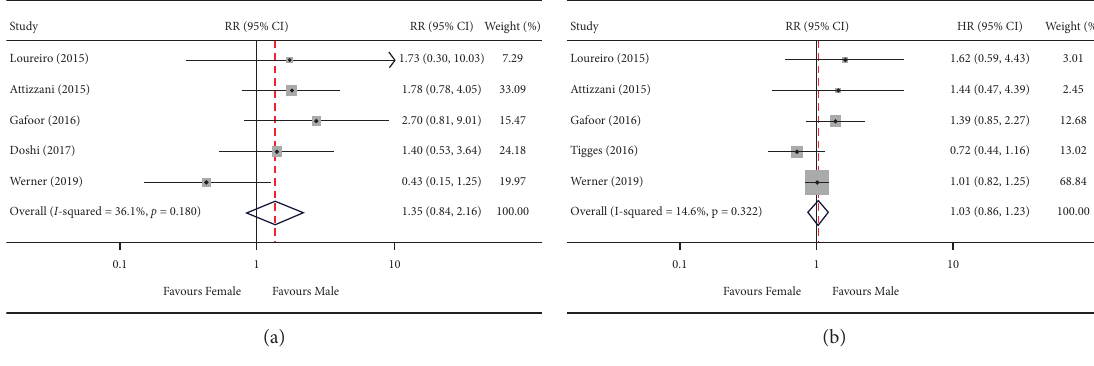
Figure 2: Male versus female. (a) Risk ratio with 95% CI for the composite endpoint of in-hospital mortality; (b) hazard ratio with 95% CI for the composite endpoint of long-term